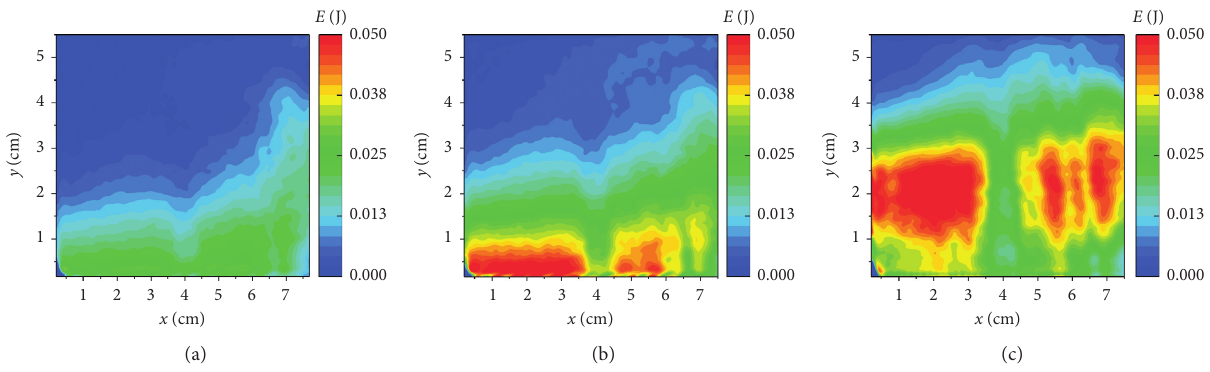
Figure 17: The distribution of the kinetic energy in different working conditions. (a) B25S. (b) B25M. (c)